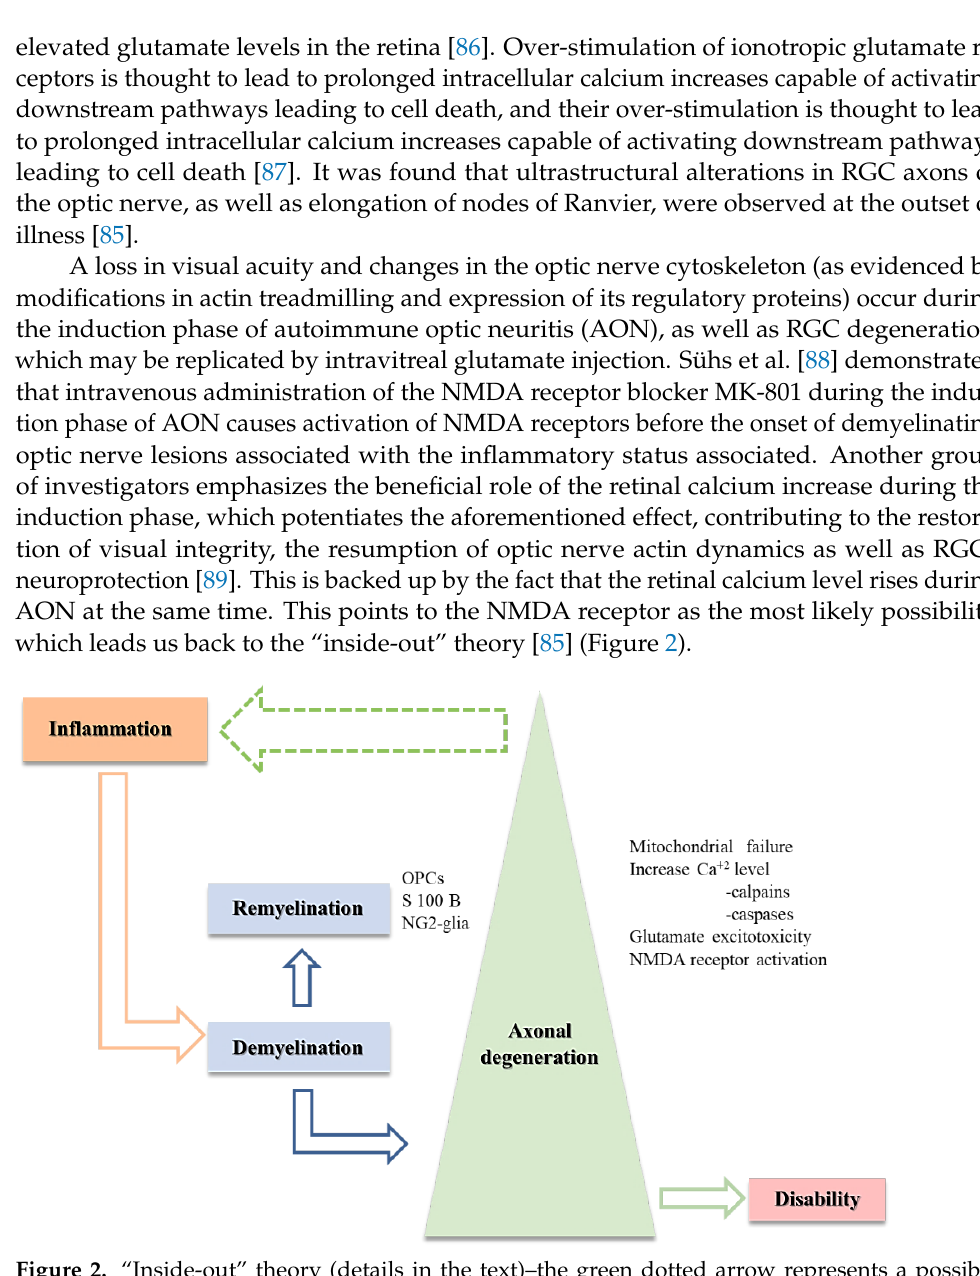
Figure 2. “Inside-out” theory (details in the text)–the green dotted arrow represents a possible Figure 2. “ Inside-out ” theory (details in the text) – the green dotted arrow represents a possible tem- temporal, but non-causal poral, but non-causal relationship.